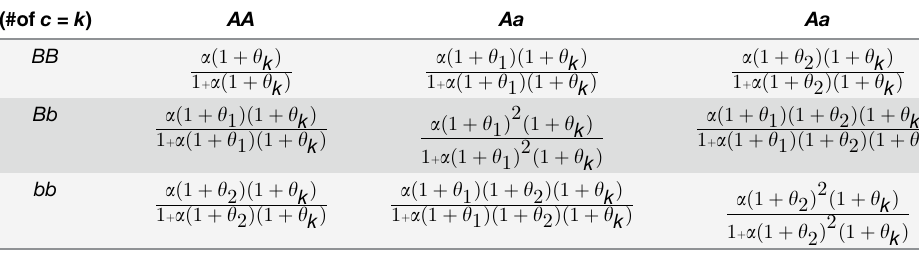
Table 2. Penetrance table for Table 1 in three causal SNP model ( θ 0 = 0).